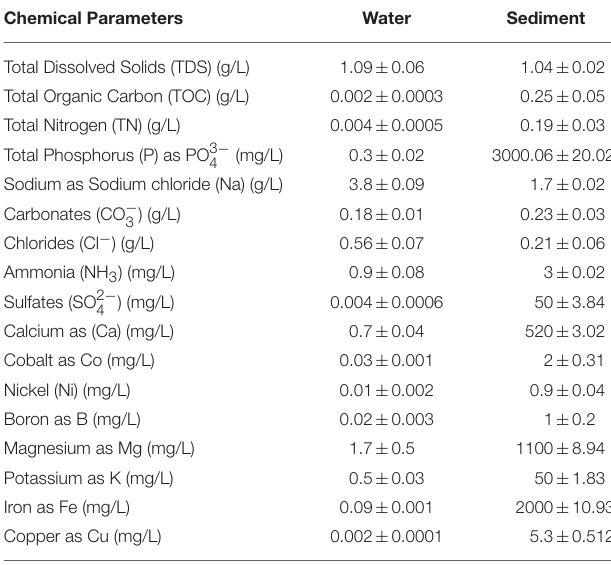
TABLE 1 | Physiochemical analysis of water and sediment